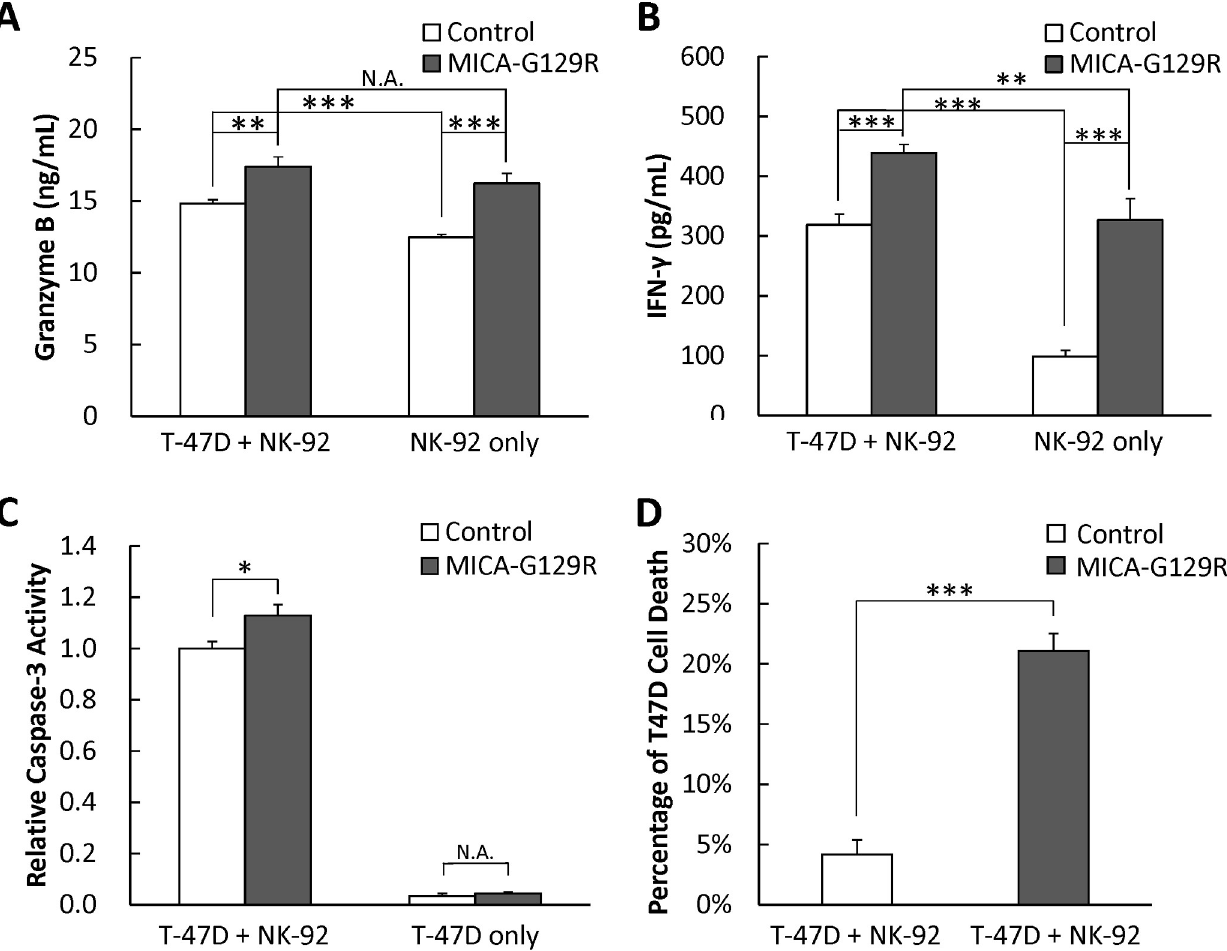
Fig 5. Purified fusion protein MICA-G129R fusion protein activats NK-92 cells. NK-92 cells, T-47D cells, or NK-92 cells with T-47D cells at the ratio of 1:1 were cultured in the media with or without the purified MICA-G129R. After 6 hours, the media were collected for ( A ) ELISA of granzyme B or ( B ) ELISA of IFN- γ . C. The activity of caspase-3 in T-47D cells from T-47 cells alone or T-47D cells co-cultured with NK-92 cells was measured using caspase-3 fluorescence assay. D. Purified MICA-G129R were evaluated in inducing the cytotoxicity in the co-culture of NK-92 cells and T-47D cells at the ratio of 1:1 for 24 hours. Data are presented as mean ± SD (n = 3). � indicates P < 0.05; �� indicates P < 0.01; ��� indicates P < 0.001.